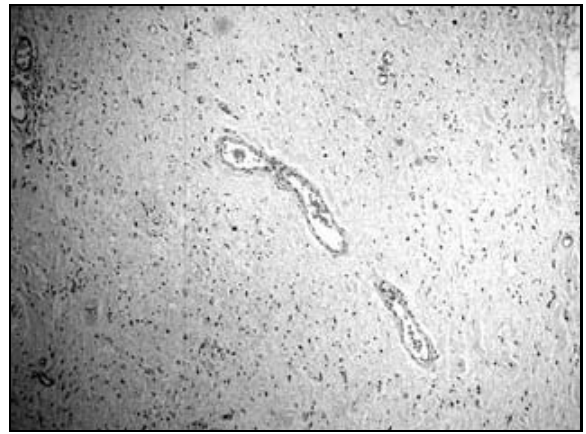
Figura 2 – Vasos sangüíneos em meio a estroma mixóide (HE 200x)